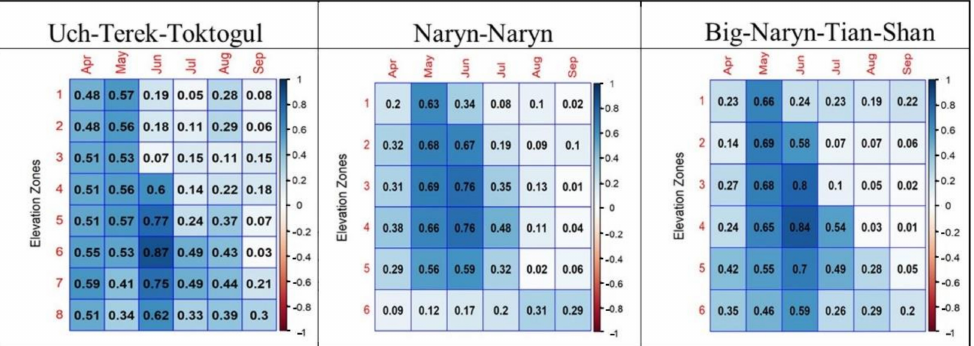
Figure 8. Correlation matrix between mean monthly discharge and snow coverage at each elevation zone.